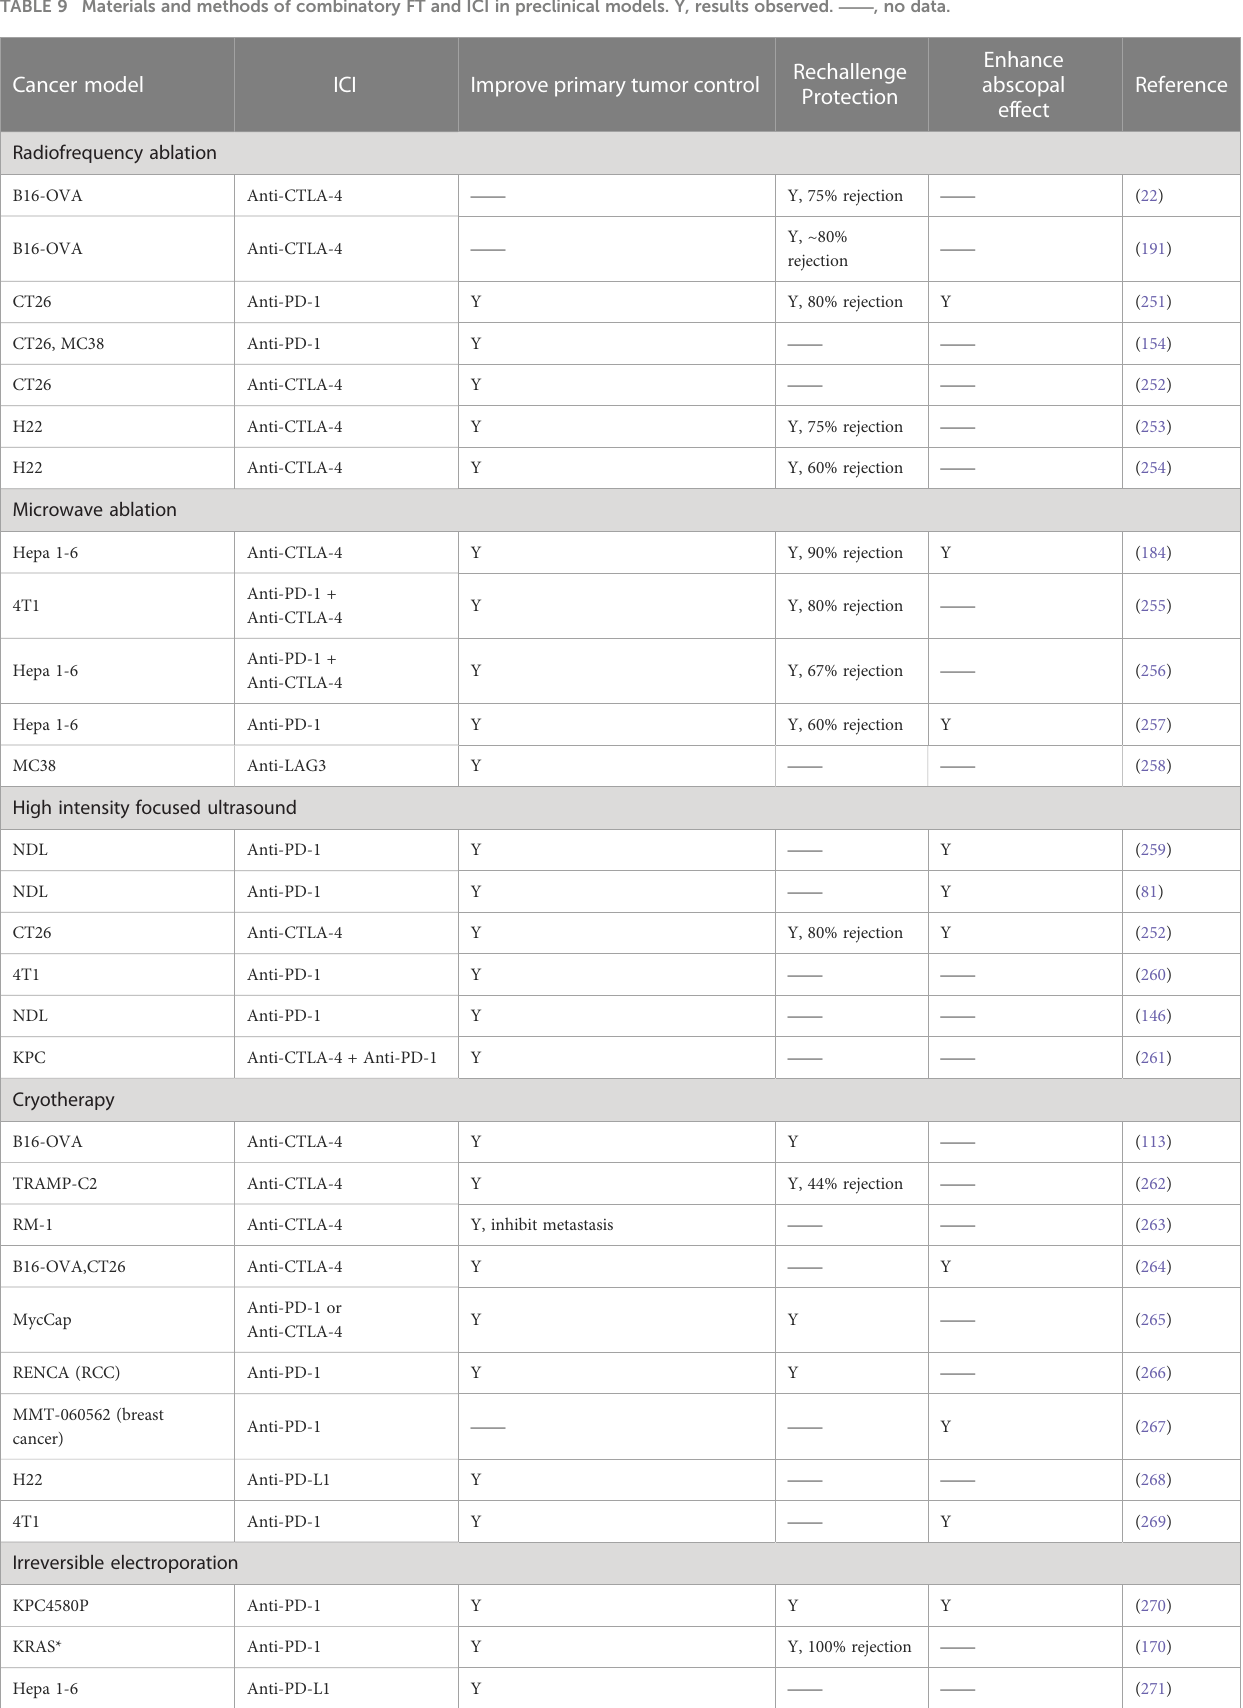
TABLE 9 Materials and methods of combinatory FT and ICI in preclinical models. Y, results observed. ― , no